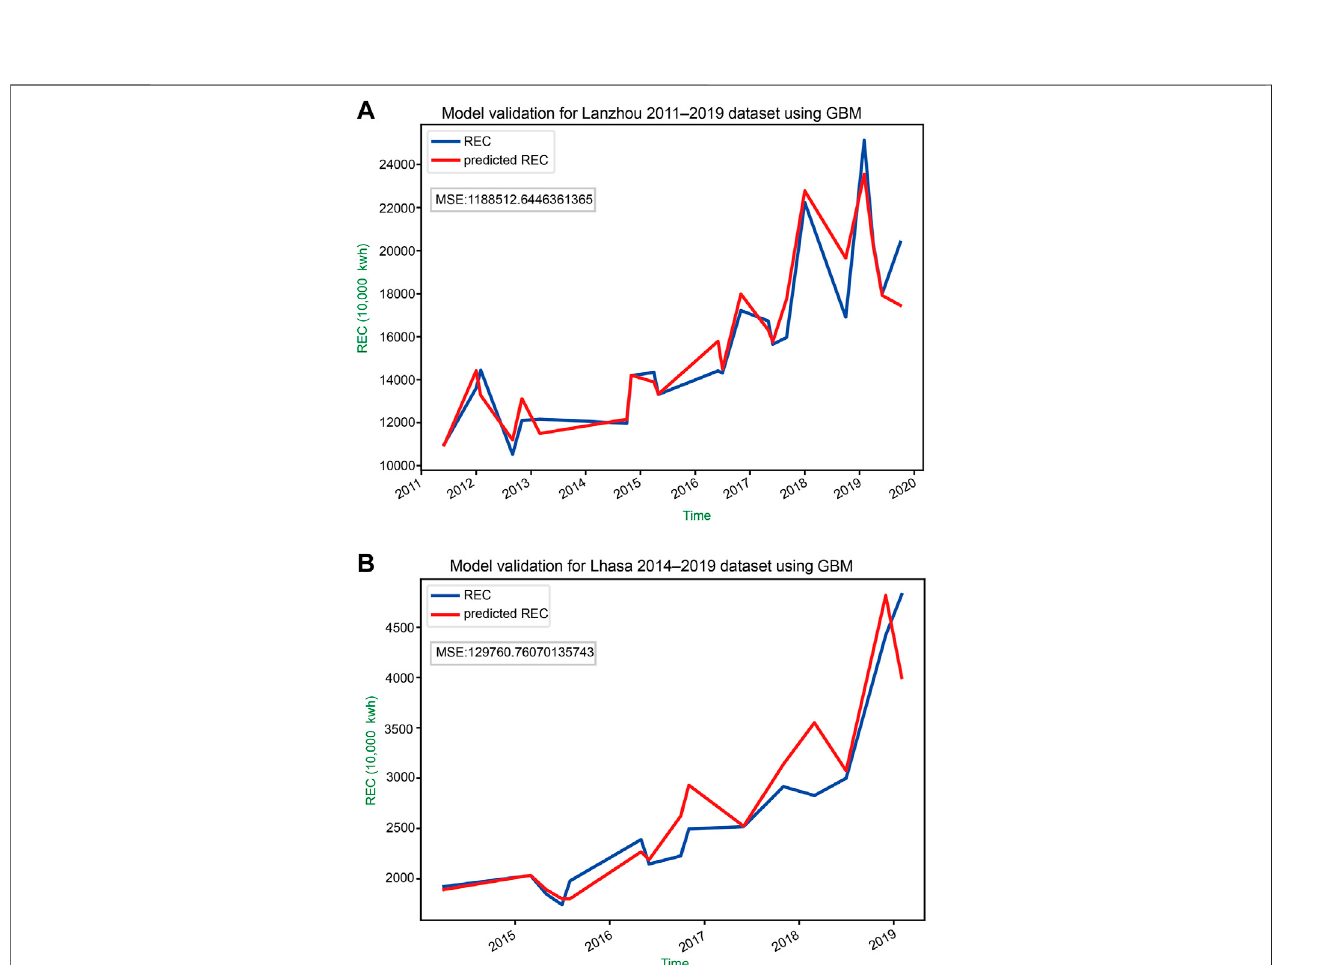
FIGURE 3 | Validation of the Lanzhou and Lhasa models. The blue line marks the reserved residential electricity consumption (REC) validation data. The red line indicates REC estimated using the corresponding model with temperature, precipitation, income, and population inputs. (A) and (B) show the validation results for models trained using datasets for Lanzhou during 2011 – 2019 and for Lhasa during 2014 – 2019, respectively.